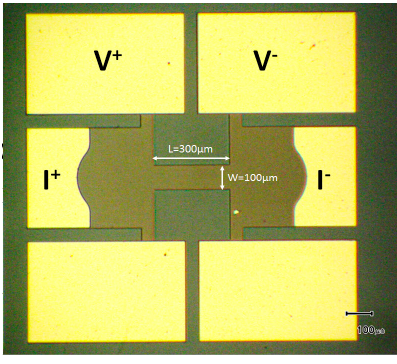
Figure 1. Optical microscope photograph of a 100 µm wide 300 µm long rectangular stripe patterned in LSMO thin